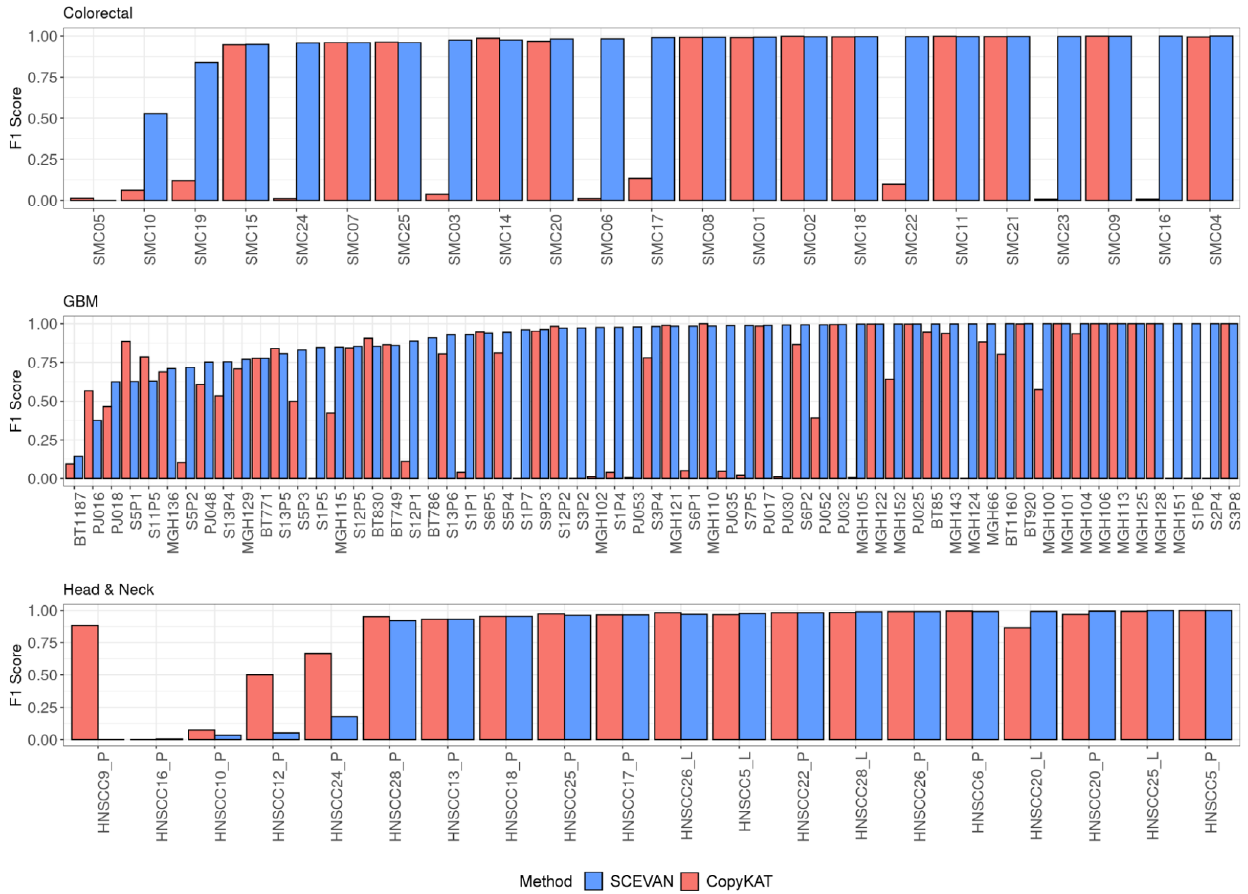
Fig. 2 | Benchmark of malignant cell classi fi cation task. F1 score obtained with SCEVAN and CopyKAT 11 in the classi fi cation of malignant and non-malignant cells for each cancer type. Colorectalcancer 20 n =47,285 cellsexamined over 23scRNA- seqindependentexperiments,Glioblastoma 7,10,22 n =40,320cellsexaminedover63